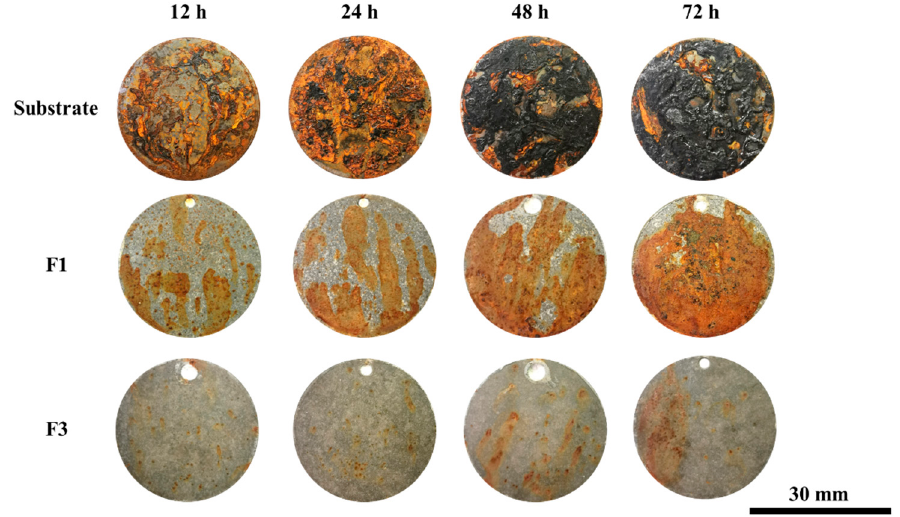
Figure 8. Salt spray corrosion of the MAO coating at different times under different negative voltages.